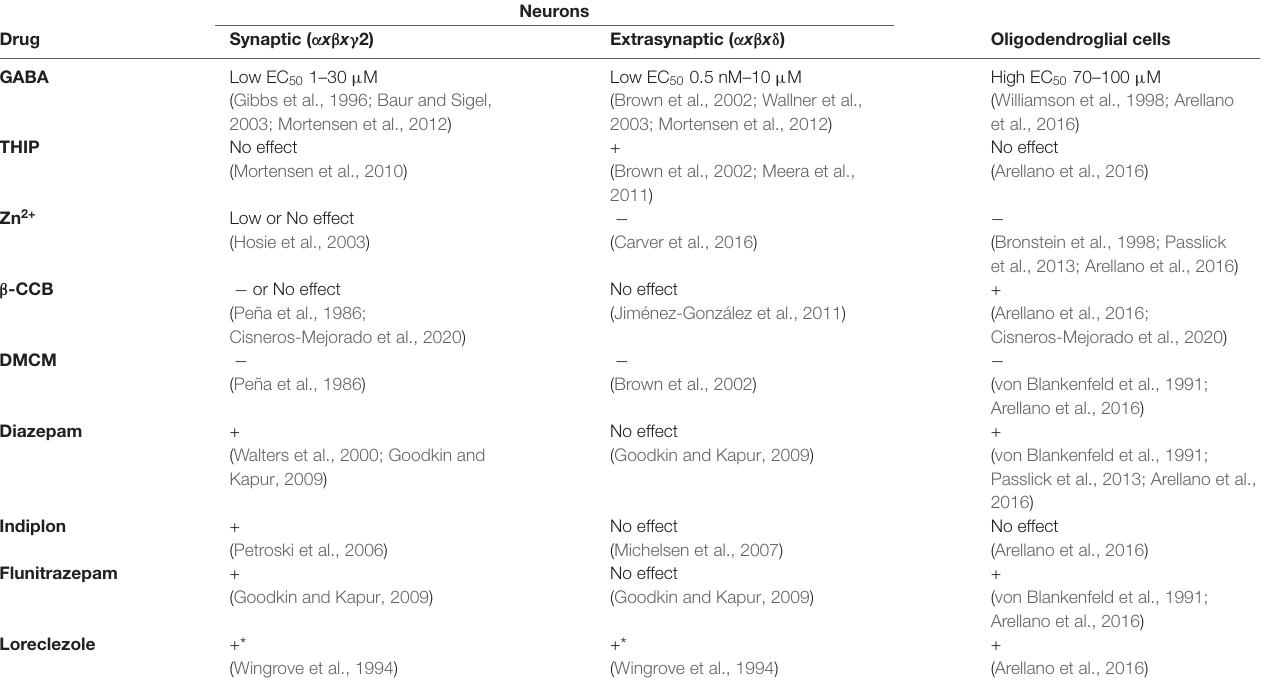
TABLE 1 | Pharmacological properties of neuronal and oligodendroglial GABA A